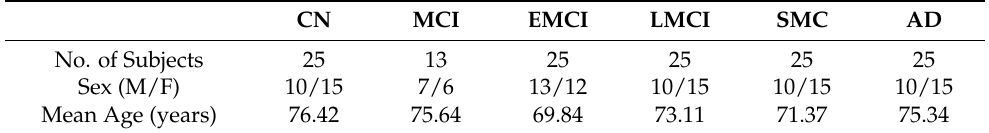
Table 2. The dataset’s demographic